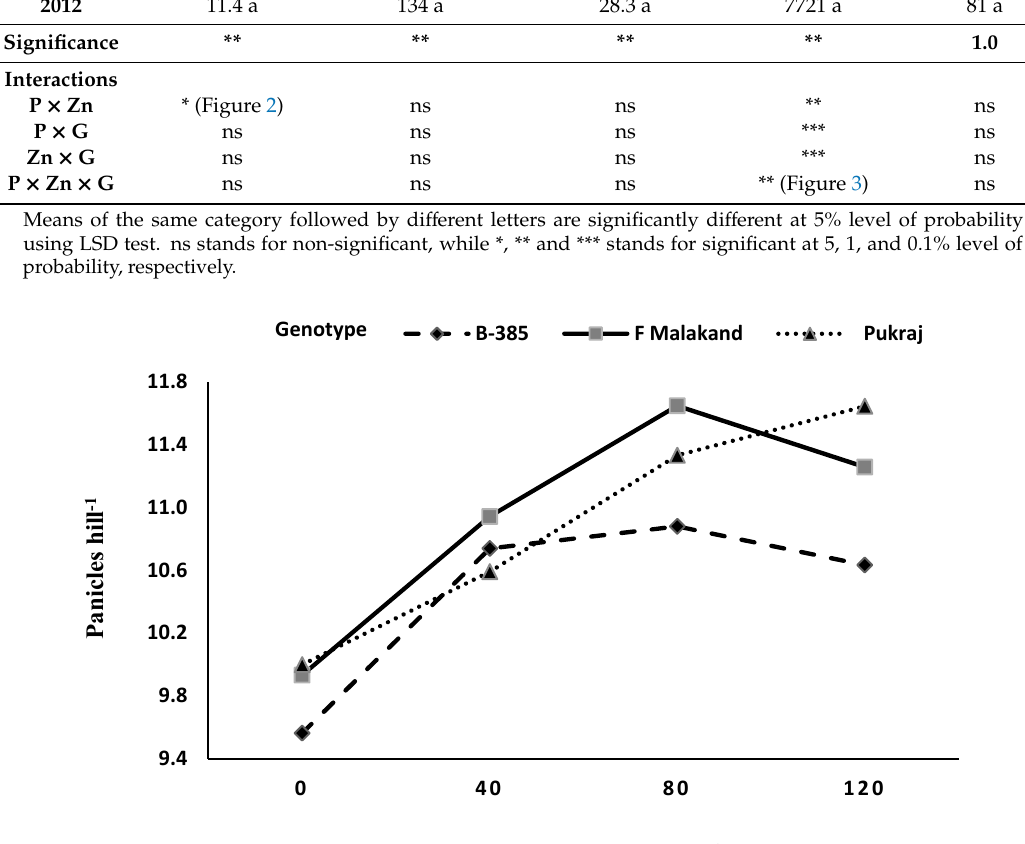
Figure 2. Number of panicles hill − 1 of rice as affected by phosphorus into genotype (P × G) interaction.